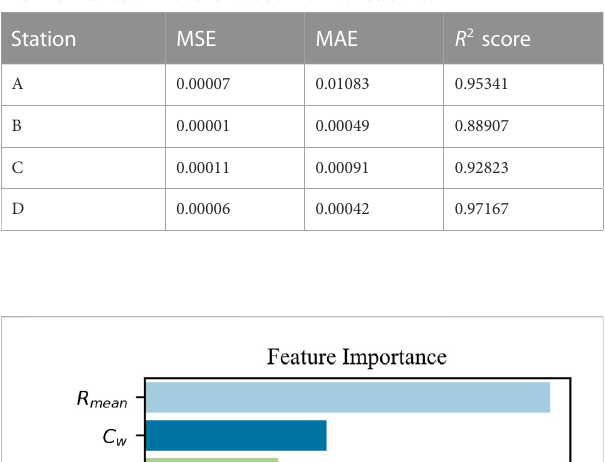
TABLE 5 Prediction model evaluation for four stations.